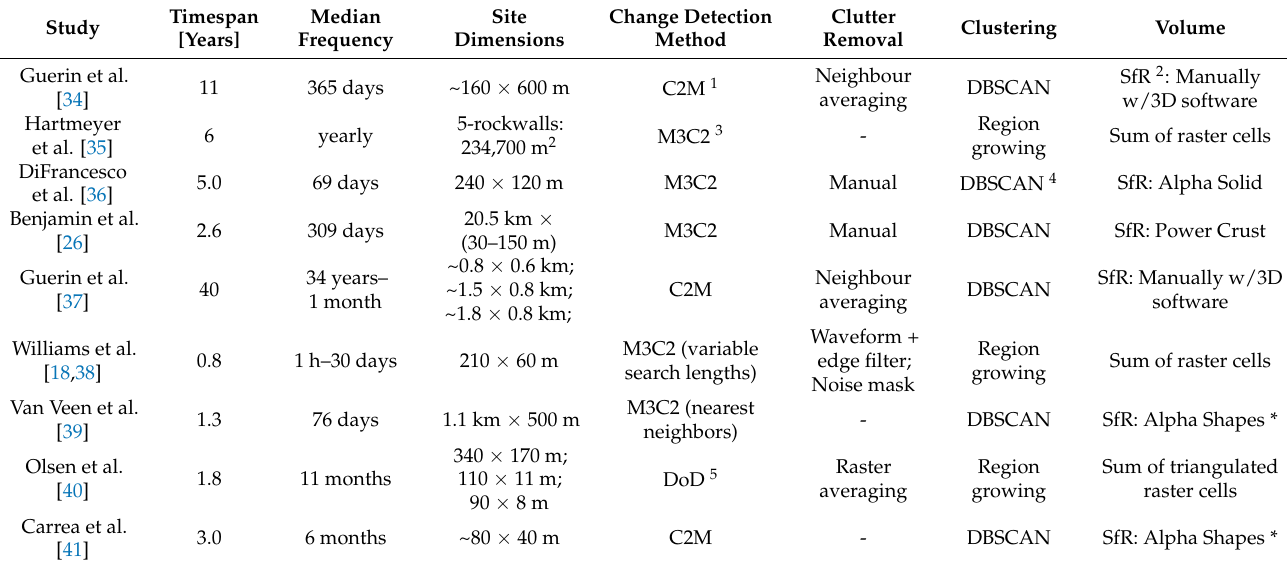
Table 1. Summary of several recent rockfall extraction methodologies, ordered by the most recent publications. Some methods additionally conduct post-database filtering by the point cloud volumes, number of points, or the change detection signature. Site dimensions preceded with a tilde indicate approximate measurements made when the dimensions were not explicitly stated in the text. Data acquisition frequencies were taken as median, or as fact from the texts.